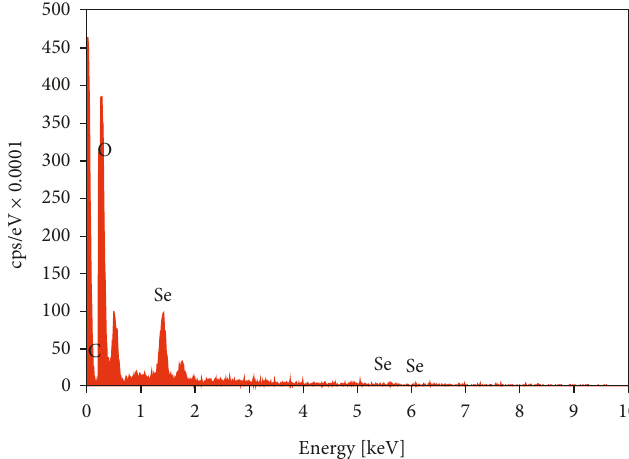
Figure 4: Energy dispersive X-ray (EDX) spectrums of selenium nanoparticles.